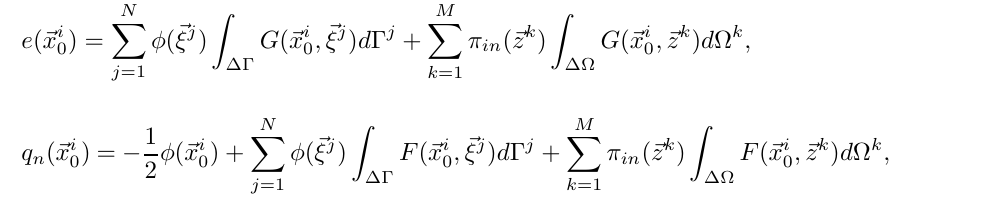
where (cid:24)x i 0 is the position vector of the midpoint of the i th boundary element. If linear elements are used in the discretizaton, discrete approximations similar to Eqs (28), (29) and (30) can be easily derived except that e , q n and φ cannot be taken out of the integral sign and c ( (cid:24)ξ ) is not 1/2. From discrete equations applied to the boundary conditions, the unknown boundary values are determined, and the energy density and intensity in the domain are finally